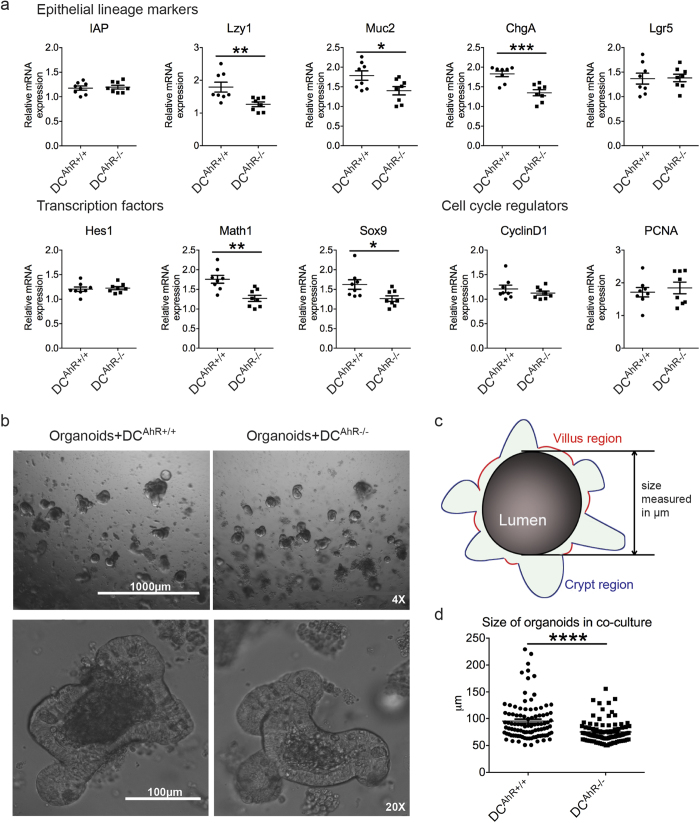
Differentiation of progenitors into secretory cell types are reduced in organoids co-cultured with AhR-deficient DCs.(a–d) CD11c+MHCIIhi DCs from the MLNs of 11cAhR +/+ or 11cAhR−/− mice were pooled (n = 3) and co-cultured with isolated small intestinal crypts from AhRfl/fl mice. Co-cultures were kept for five days. (a) Relative expression of epithelial lineage markers, transcription factors and proliferative markers were examined via quantitative RT-PCR. Each symbol represents a single biological replicate and data presented as mean ± SEM. Dataset shown was one out of two independent experiments performed with similar results. (b) Bright-field images of co-cultures are shown at different optical zooms. (c) Schematic showing how sizes of organoids were measured. (d) Size of organoids co-cultured presented as ±SEM from the two groups. Student’s t-test: *P < 0.05; **P < 0.01; ***P < 0.001; ****P < 0.0001.